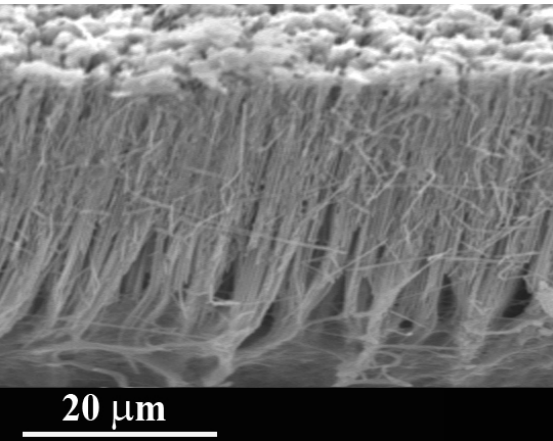
Fig.2. Cross-sectional SEM image of FeCoNi nanowire arrays with length of 32  mafter release and elimination of dendritic NWs.